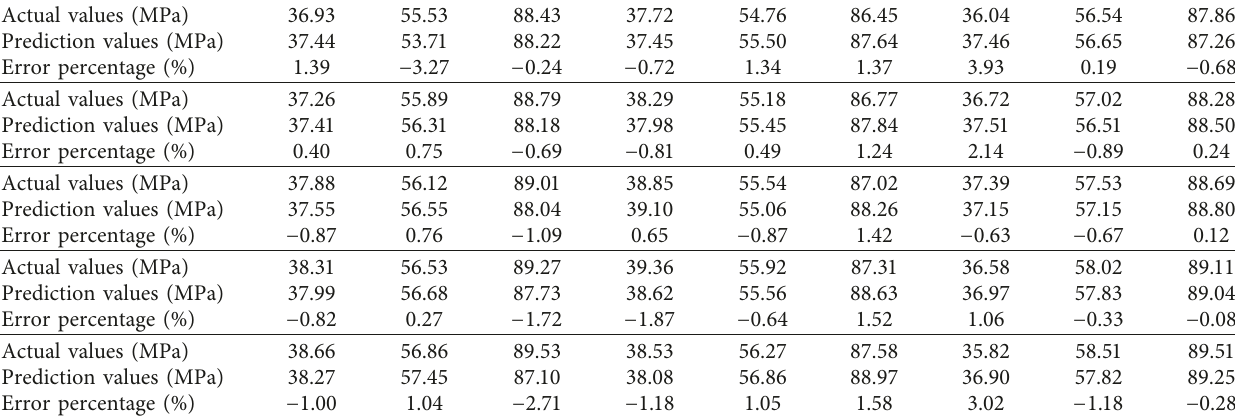
Figure 10: Distributions of the prediction value and actual value. Table 9: Error percentage of actual values and prediction values.